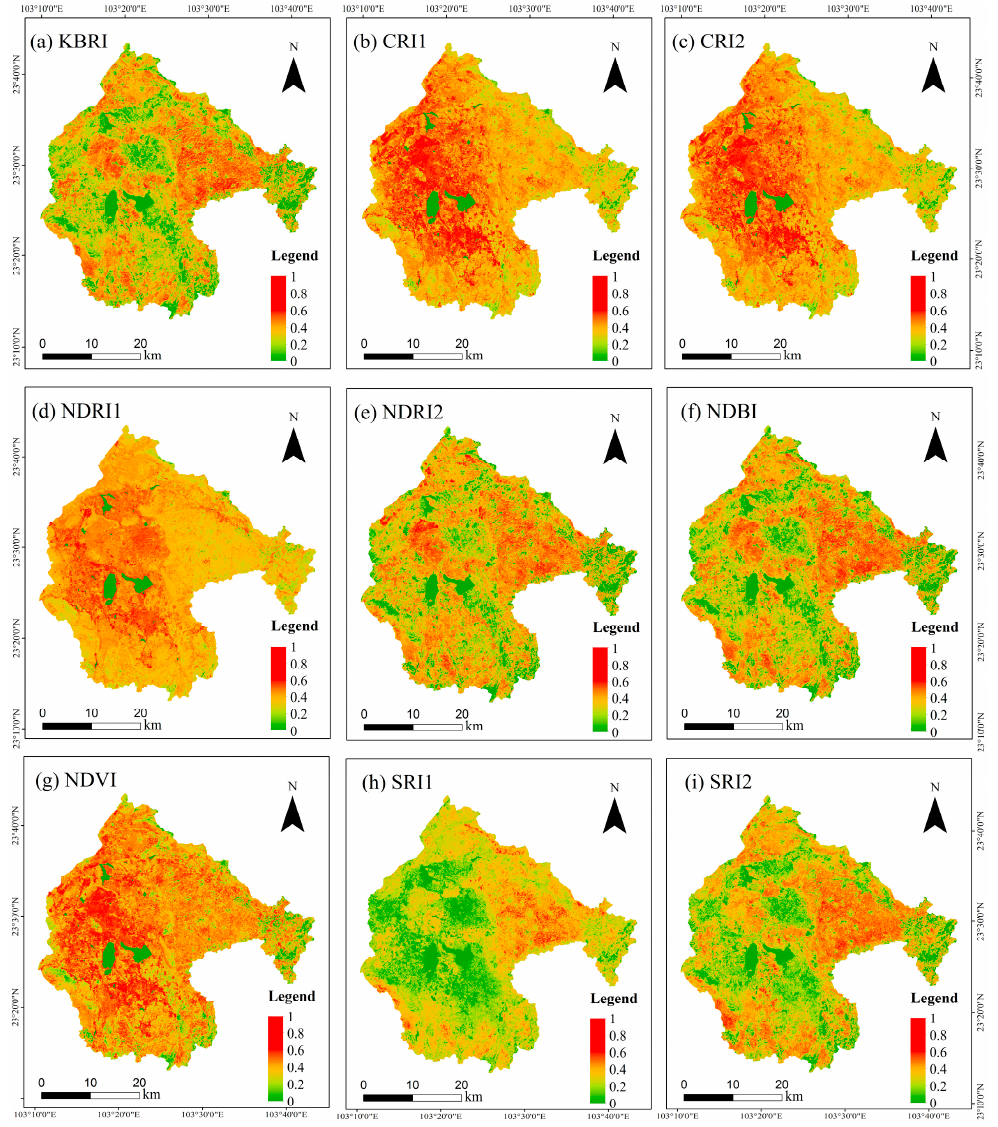
Figure 6. Images of exposed bedrock fractions throughout the whole Nandong watershed developed by the linear regression models with ( a ) KBRI, ( b ) CRI1, ( c ) CRI2, ( d ) NDRI1, ( e ) NDRI2, (f) NDBI, ( g ) NDVI, ( h ) SRI1, and ( i ) SRI2, whose values range from 0 and 1, where 0 represents nonrock areas, and 1 denotes 100% exposed bedrock coverage.